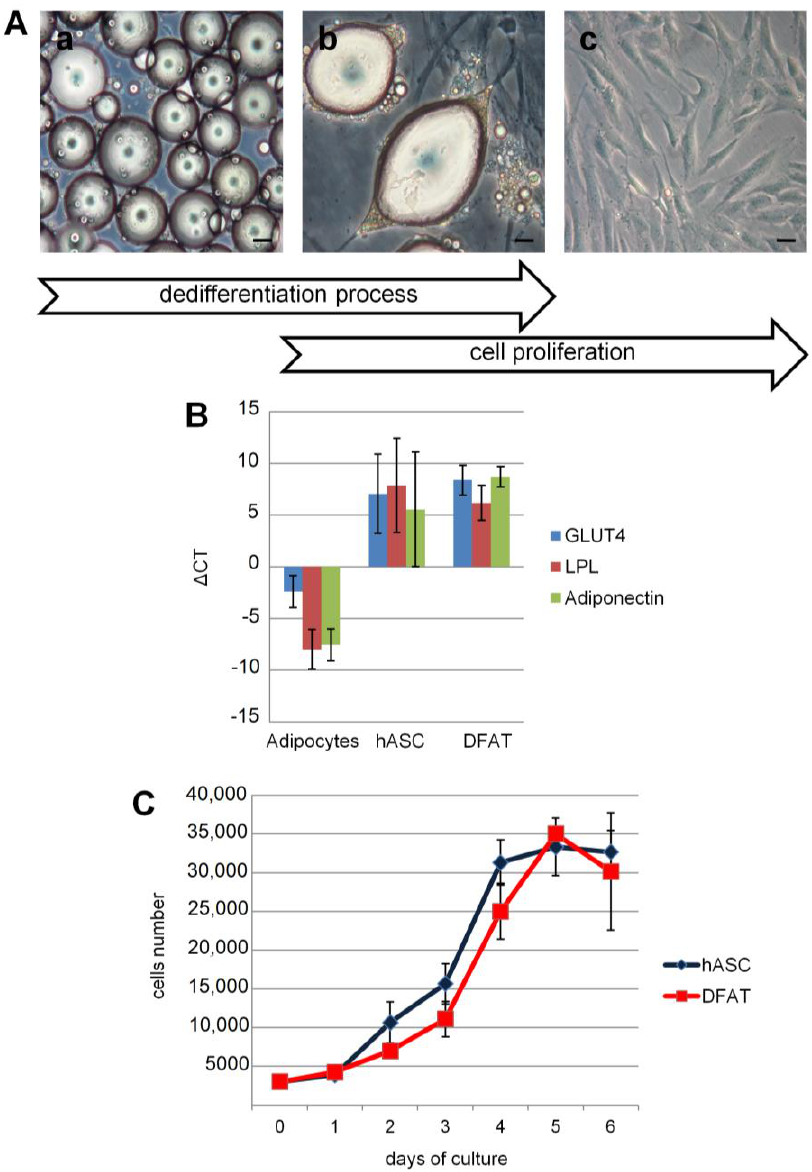
Figure 1. Dedifferentiation process and culture of mature adipocytes. ( A ) At day 0, mature adipocytes flattened to the upper surface of the flask ( a ). During the seven day-culture period, cells underwent a differentiation process: they lost the lipid content ( b ) and attached to the flask